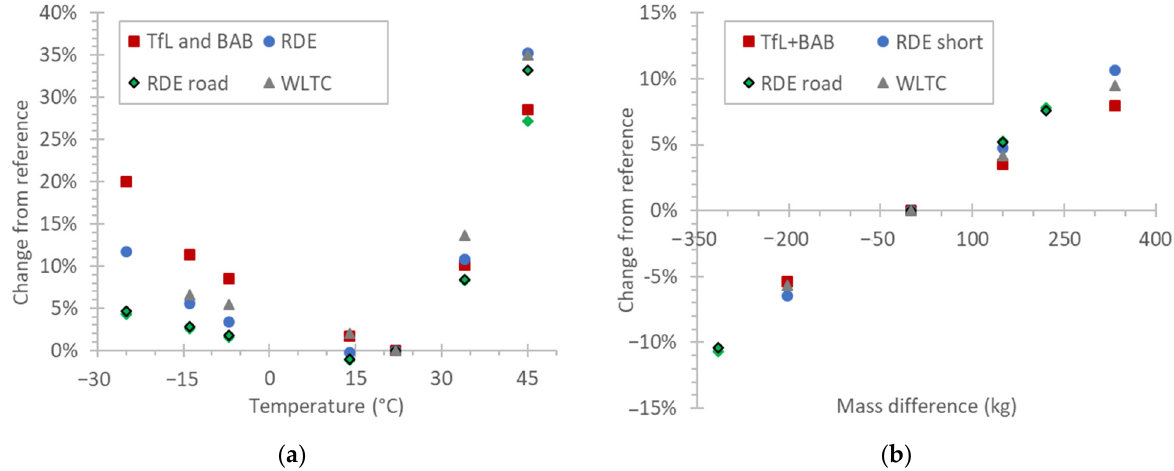
Figure 8. Simulation results of the effect of various parameters on CO 2 emissions. The base is the test at 23°C. ( a ) Ambient temperature; ( b ) vehicle total mass.